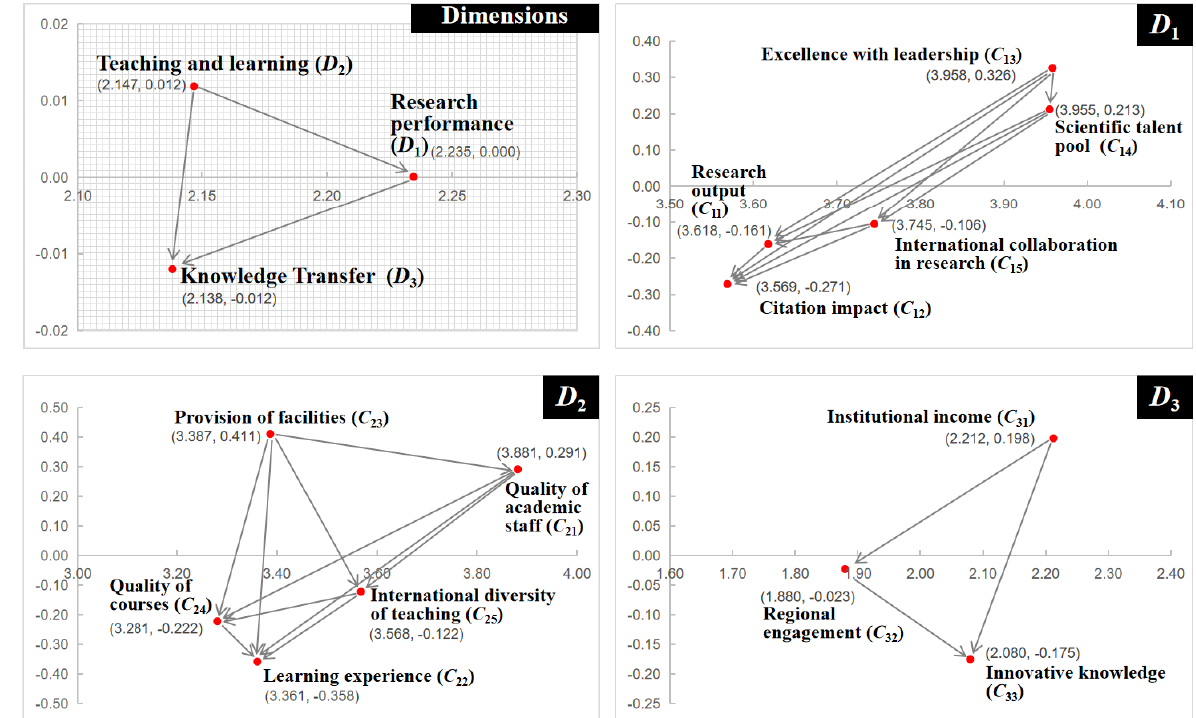
Figure 3. An influential network relationship map (INRM). It shows the influential relationships among the criteria and also the dimensions.